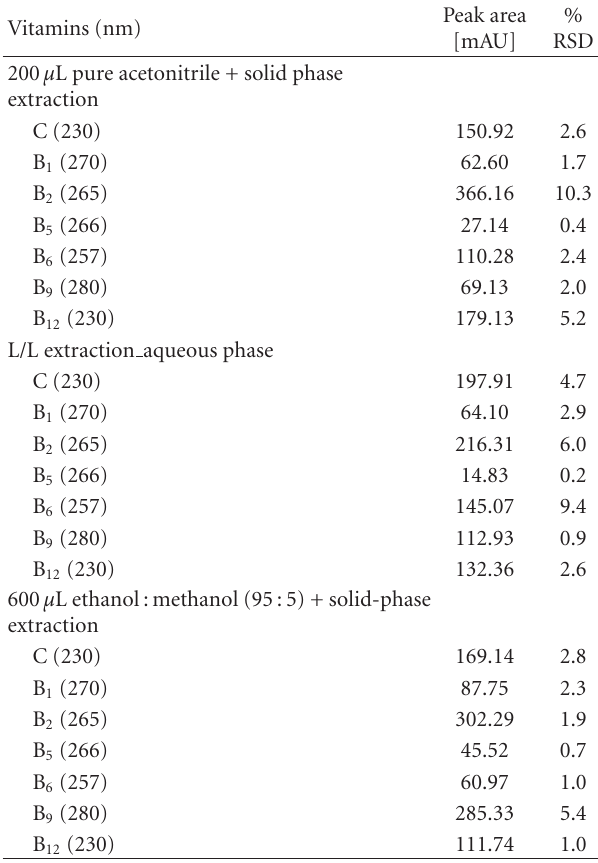
Table 3: Method optimisation results. Results from the sample preparation method optimisation for vitamins spiked in artificial plasma samples processed using each of the three methods men- tioned above. Results are reported as mean of peak area ± RSD ( n = 3). Numbers in parenthesis indicate wavelength used for